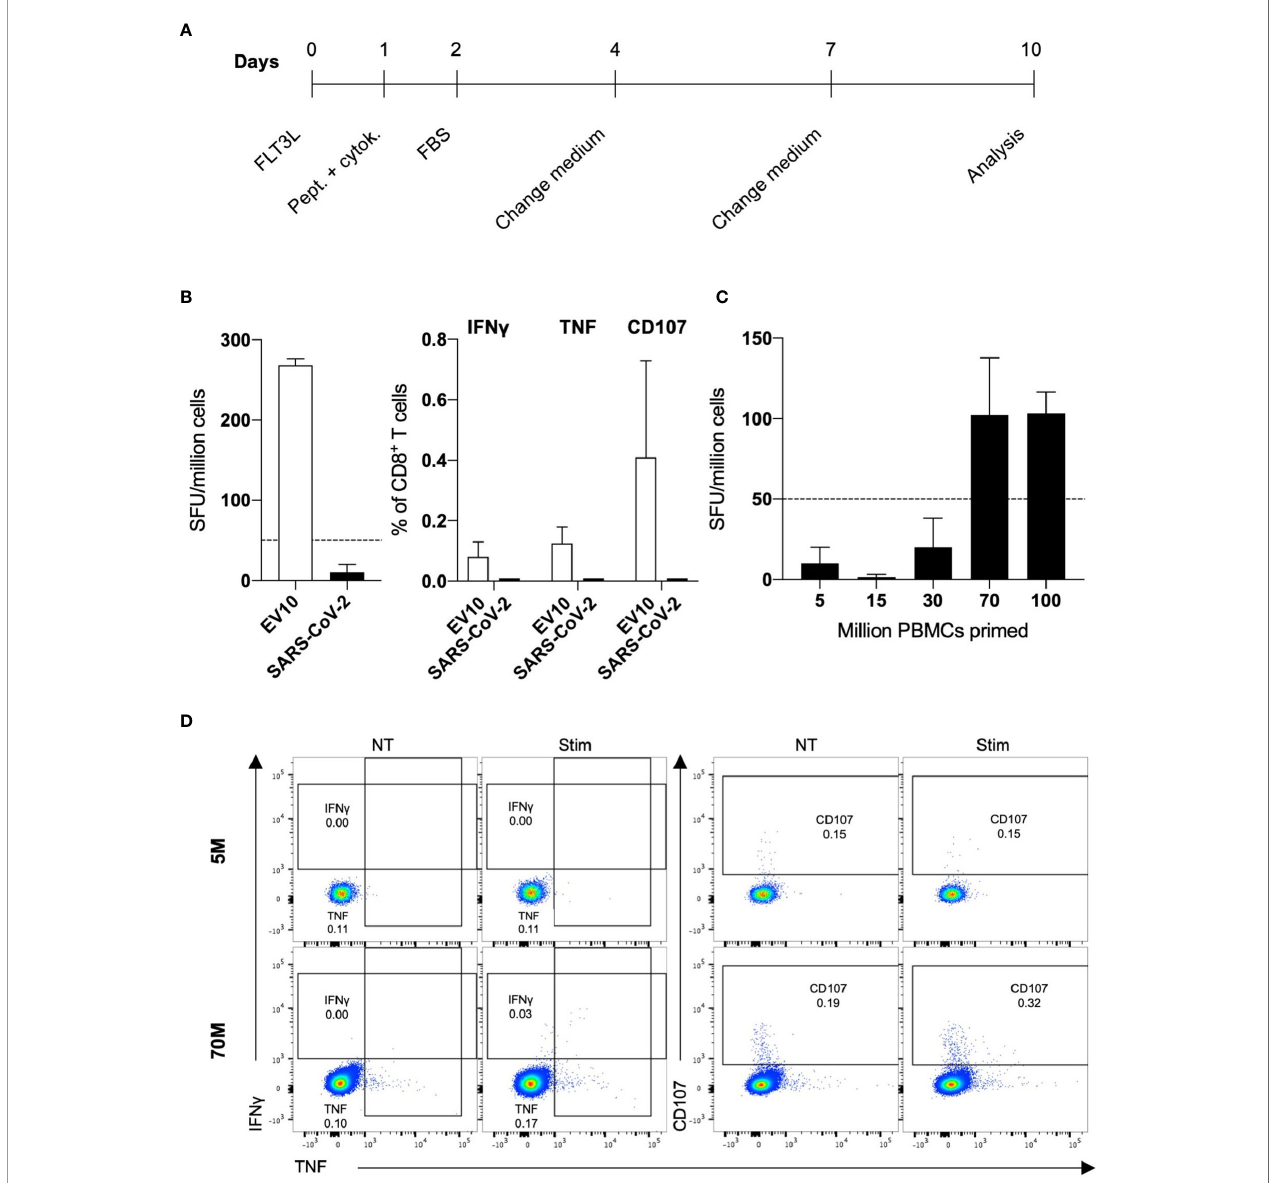
FIGURE 1 | In vitro priming of SARS-CoV-2-speci fi c naive CD8 + T cells in healthy donors. (A) Scheme of the in vitro priming protocol. (B) PBMCs (5 × 10 6 ) were primed with EV10 or a pool of 37 SARS-CoV-2-derived peptides. After ten days, the frequency of peptide-speci fi c primed naive CD8 + T cells was measured by IFN g ELISpot (left), and the expression of IFN g , TNF, and CD107 (right) was assessed by ICS. Data are shown, after background (NT) subtraction, as the mean + S.E.M. of two donors. (C, D) PBMCs (5 – 100 × 10 6 ) were primed with a pool of 37 SARS-CoV-2-derived peptides. After ten days, the frequency of epitope-speci fi c primed naive CD8 + T cells was measured by IFN g ELISpot, and the expression of IFN g , TNF, and CD107 was assessed by ICS. Data are shown, after background (NT) subtraction, as the mean + S.E.M. of three donors (C) . One representative dot plot for stimulation of 5 and 70 × 10 6 PBMCs is shown (D)